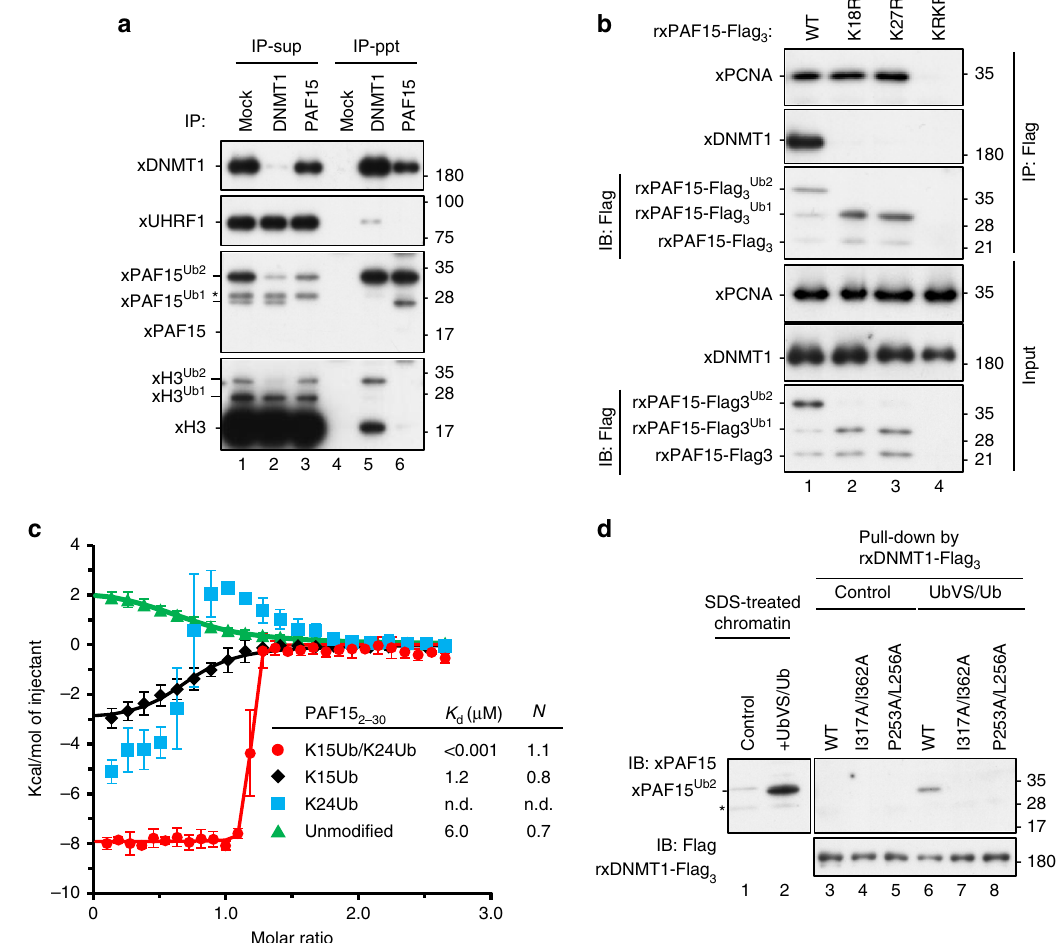
Fig. 3 PAF15Ub2 forms a complex with DNMT1. a Reciprocal immunoprecipitation of PAF15 and DNMT1 from chromatin lysates. IP was performed with control (Mock), anti-xDNMT1 (DNMT1), or anti-xPAF15 (PAF15) antibody from chromatin lysates. Supernatants after immunoprecipitation (IP-sup) or immunoprecipitates (IP-ppt) were analyzed by immunoblotting using the indicated antibodies. b Sperm chromatin was replicated in interphase egg extracts containing xPAF15-Flag 3 [wild-type, K18R, K27R, or K18RK27R (KRKR)]. Isolated and solubilized chromatin proteins were subjected to immunoprecipitation using anti-Flag antibodies. The resultant immunoprecipitates were analyzed by immunoblotting using the indicated antibodies. c Superimposition of plots of enthalpy changes in the interaction between hRFTS and hPAF15 2-30 or its ubiquitylated analogs by ITC measurement. d Pull-down of ubiquitylated PAF15 from denatured chromatin extracts using recombinant wild-type xDNMT1-Flag 3 and its ubiquitin-binding mutants (P253AL256A or I317AI362A). Source data are provided as a Source Data fi